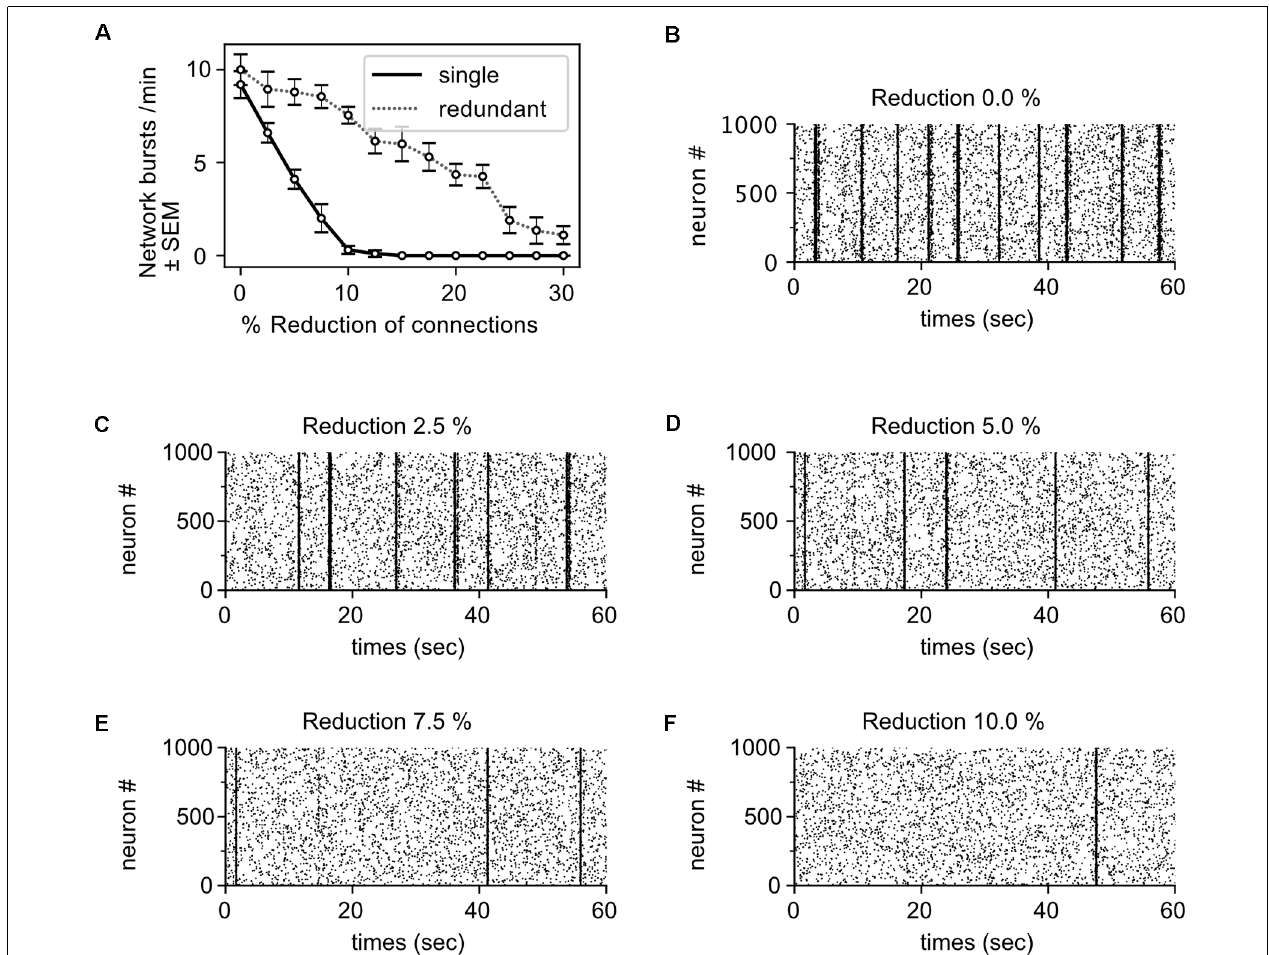
FIGURE 8 | Moderate reductions in outbound connectivity cause robust reductions in intrinsic network activity. (A) The frequency of network bursts decreases with the reduction of synapses (i.e., outbound connections), assuming mono-synaptic connectivity (single, black solid line) or multiple, redundant synaptic connectivity with compensation (redundant, dotted gray line). Raster plots show network activity for the mono-synaptic connectivity with different levels connectivity: 100% connectivity (B) , 97.5% connectivity (C) , 95% connectivity (D) , 92.5% connectivity (E) , and 90% connectivity (F) . Dots represent single spikes, lines the network